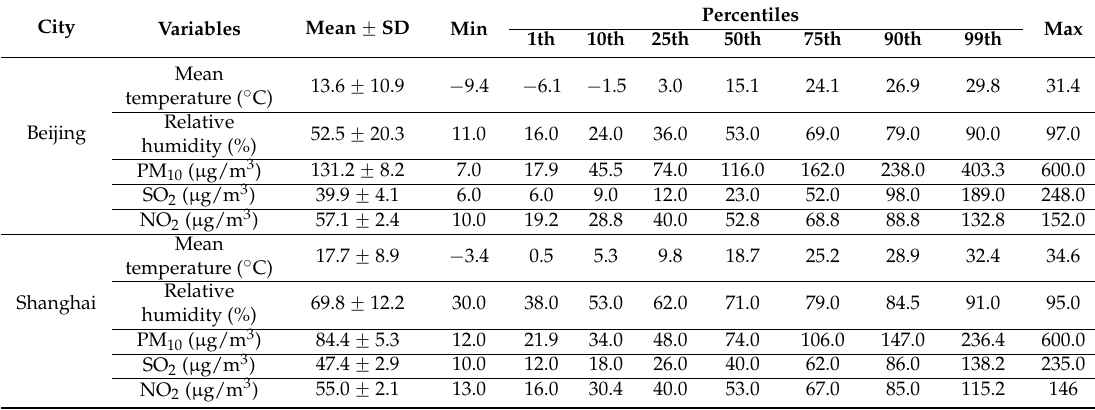
Table 2. Summary statistics of weather conditions and air pollutants during 2007–2009 in Beijing and Shanghai,